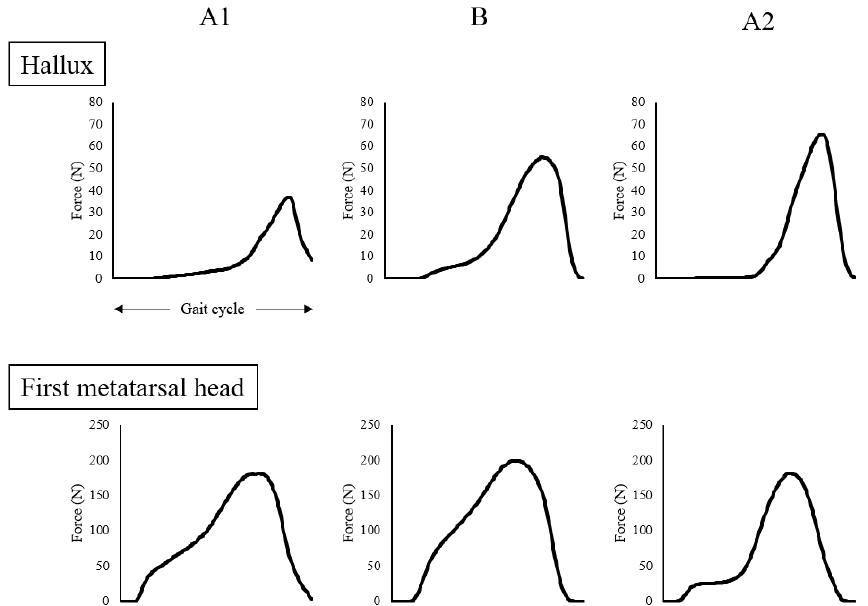
Figure 4. Waveform obtained by adding and averaging the vertical force component of three gait cycles under the hallux and first metatarsal.